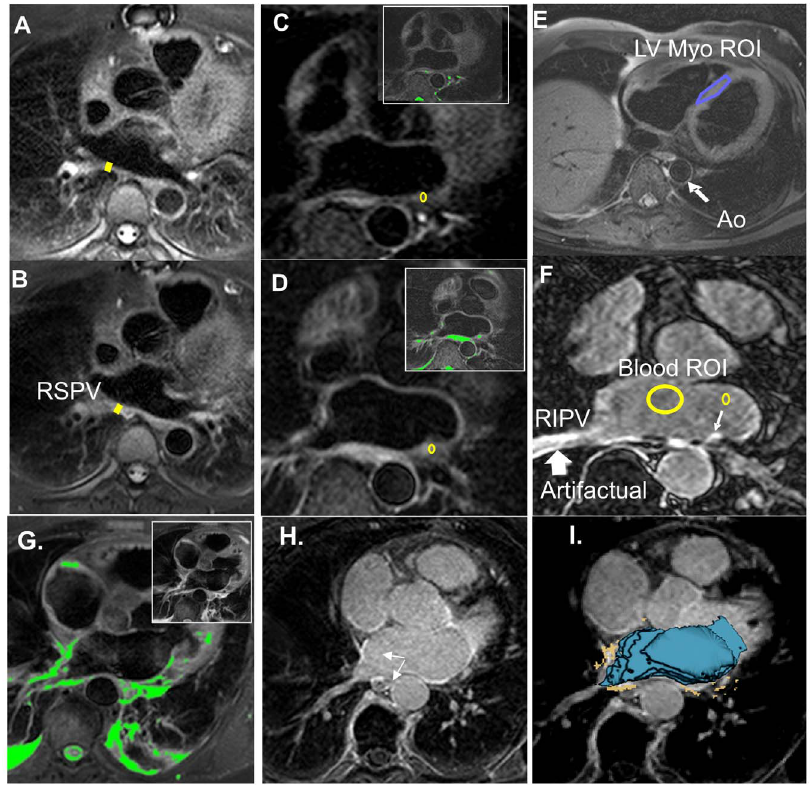
Figure 2. Methods of data analysis. A-B) T2W images from a subject imaged pre pulmonary vein isolation (PVI) (A) and 24-hour post PVI (B), used for measuring right superior PV wall thickness, as shown; note the prominent LA wall thickening. C-F) Another subject imaged pre-pulmonary